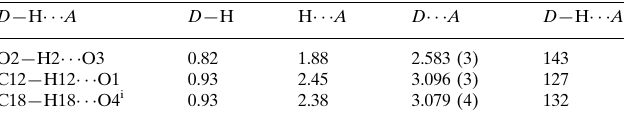
Hydrogen-bond geometry (A˚ , (cid:1)